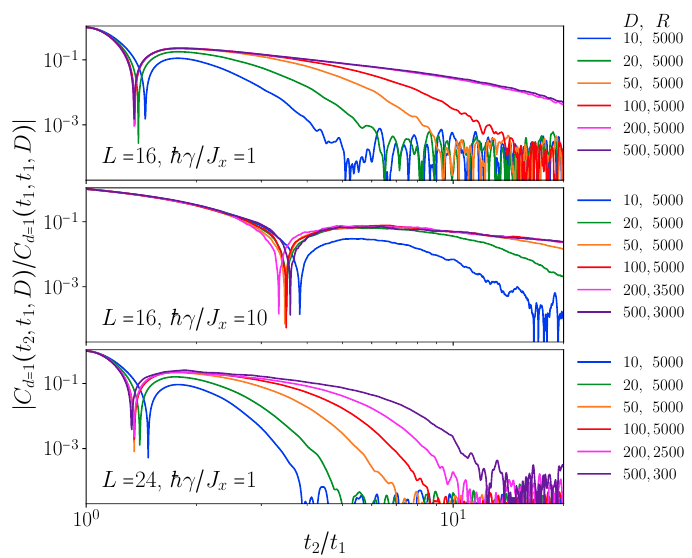
Figure 12: Convergence of two-time correlations obtained from MCWF using the method by Breuer et al. for different system sizes L and dissipation strengths and a spin interaction anisotropy J goal (cid:34) = 0 and a time step ∆ tJ (cid:126) γ/ J = 10. The bond dimension D and the number of MC samples R are given for x each curve.